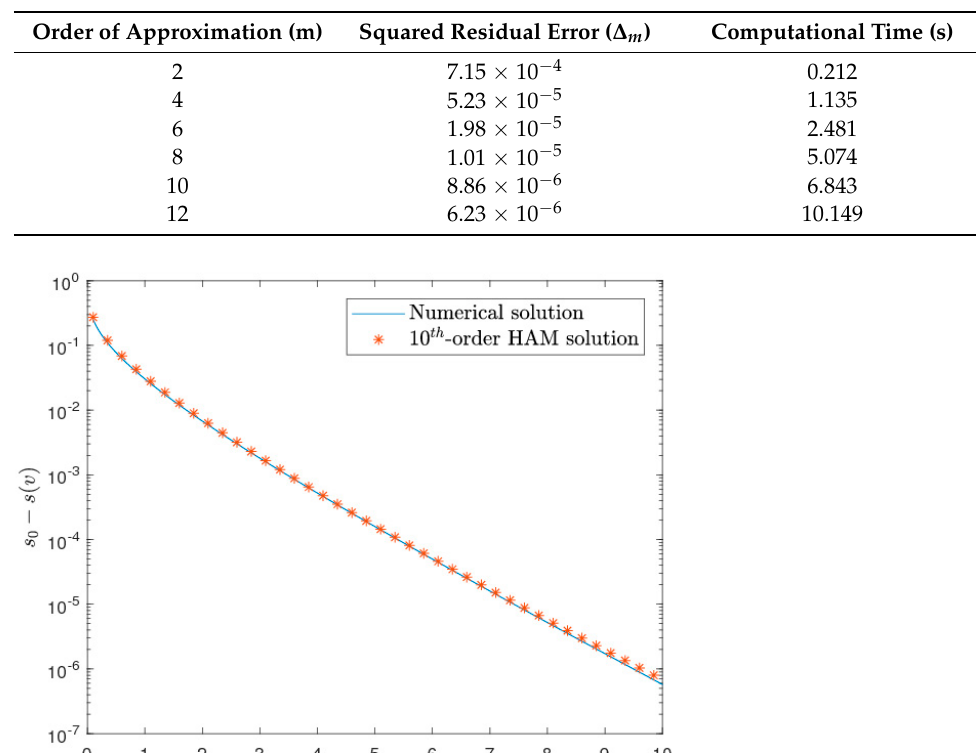
Figure 5. Squared residual error ( ∆ (cid:3040) ) versus di ff erent orders of approximations ( 𝑚 ) of the HAM- based solution for the selected case. Table 1. Squared residual error ( ∆ (cid:3040) ) and computational time versus di ff erent orders of approxima- tion ( m ) for the selected case. Table 1. Squared residual error ( ∆ m ) and computational time versus different orders of approximation (m) for the selected case.